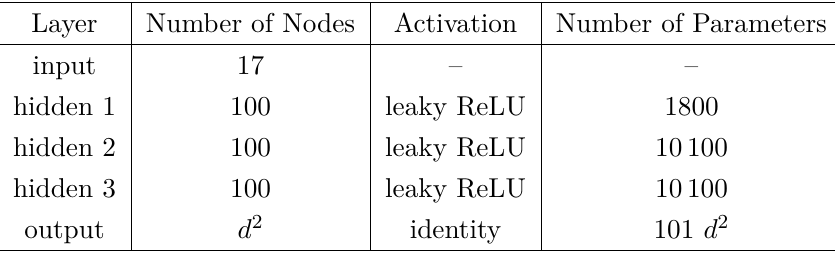
Table 2 . Neural network architecture for the neural network that approximates the CY metric directly by optimizing a loss function that combines the various consistency conditions for the CY metrics.